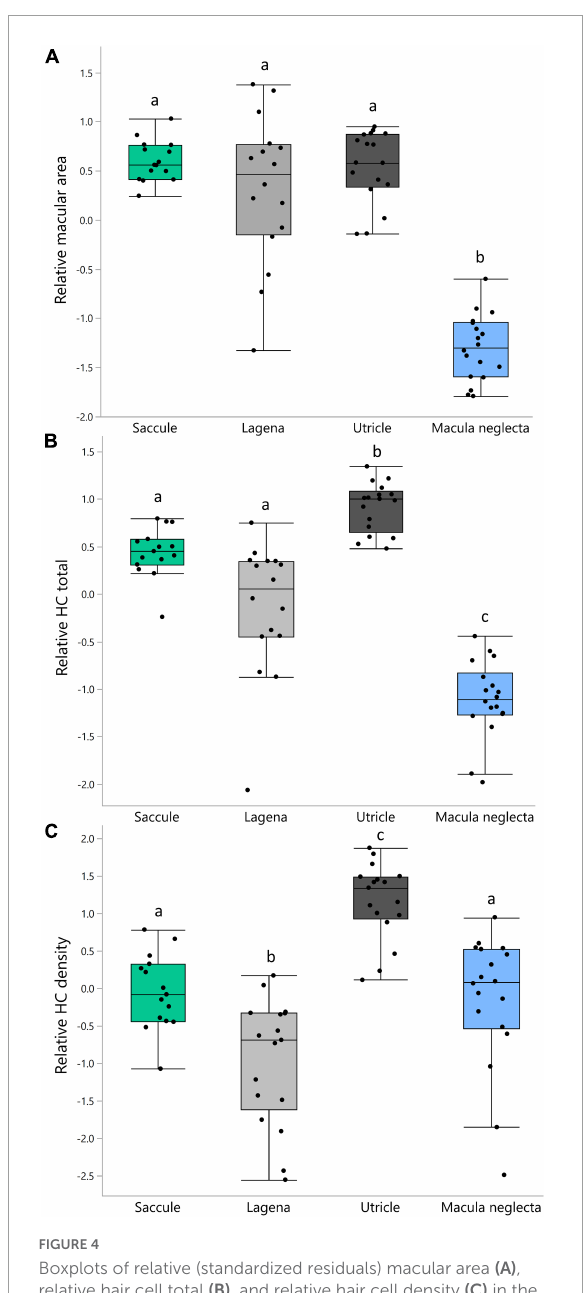
FIGURE4 Boxplots of relative (standardized residuals) macular area (A) , relative hair cell total (B) , and relative hair cell density (C) in the four inner ear maculae of Cephaloscyllium isabellum . Significantly different means ( α = 0.05) within each panel are indicated by differing lowercase